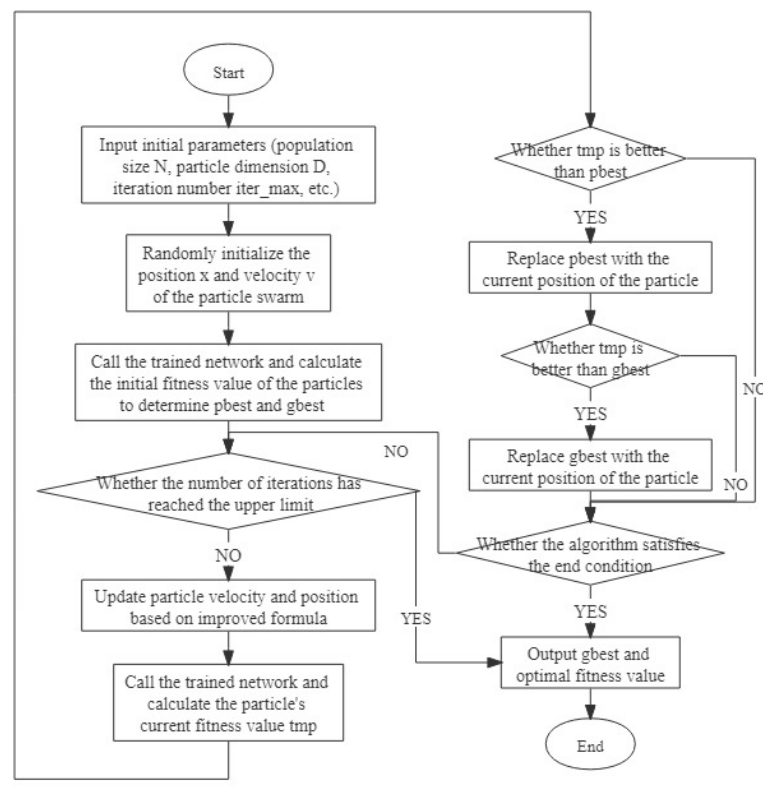
Figure 3. Optimization flow of SA-CAPSO